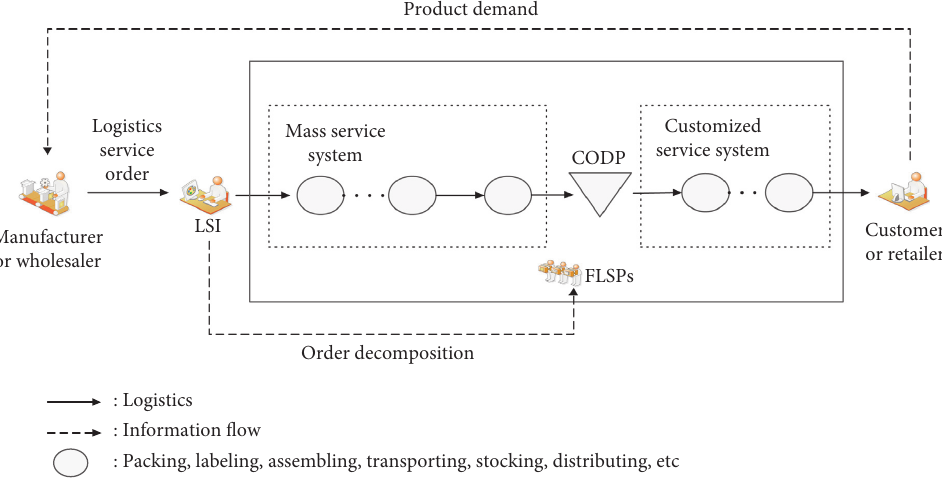
Figure 1: The logistics service supply chain structure under the mass customization environment. Table 1: Parameters for the CODP position